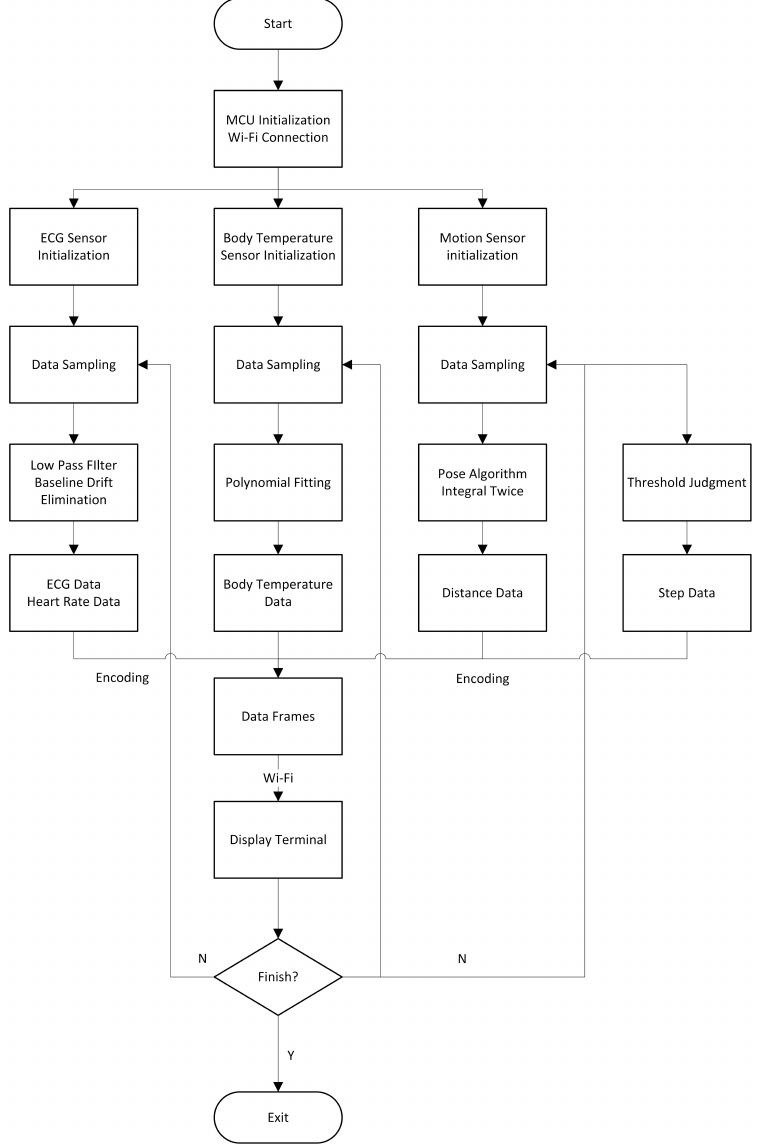
Figure 4. Overall algorithm